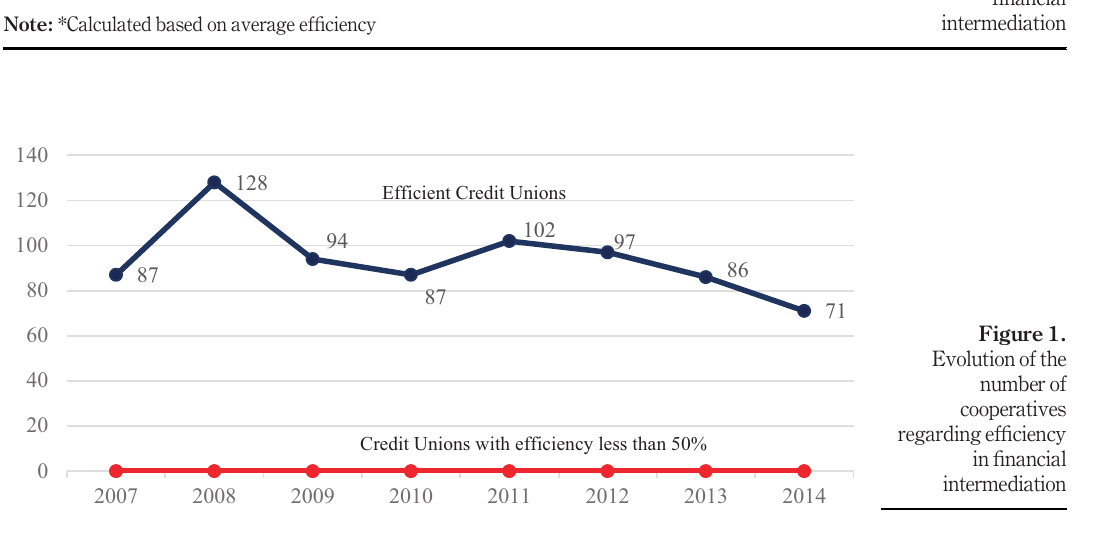
Figure 1. Evolution of